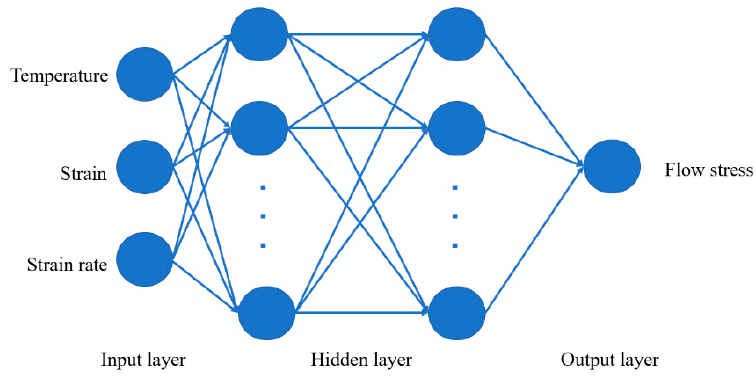
Figure 1. The basic structure of the